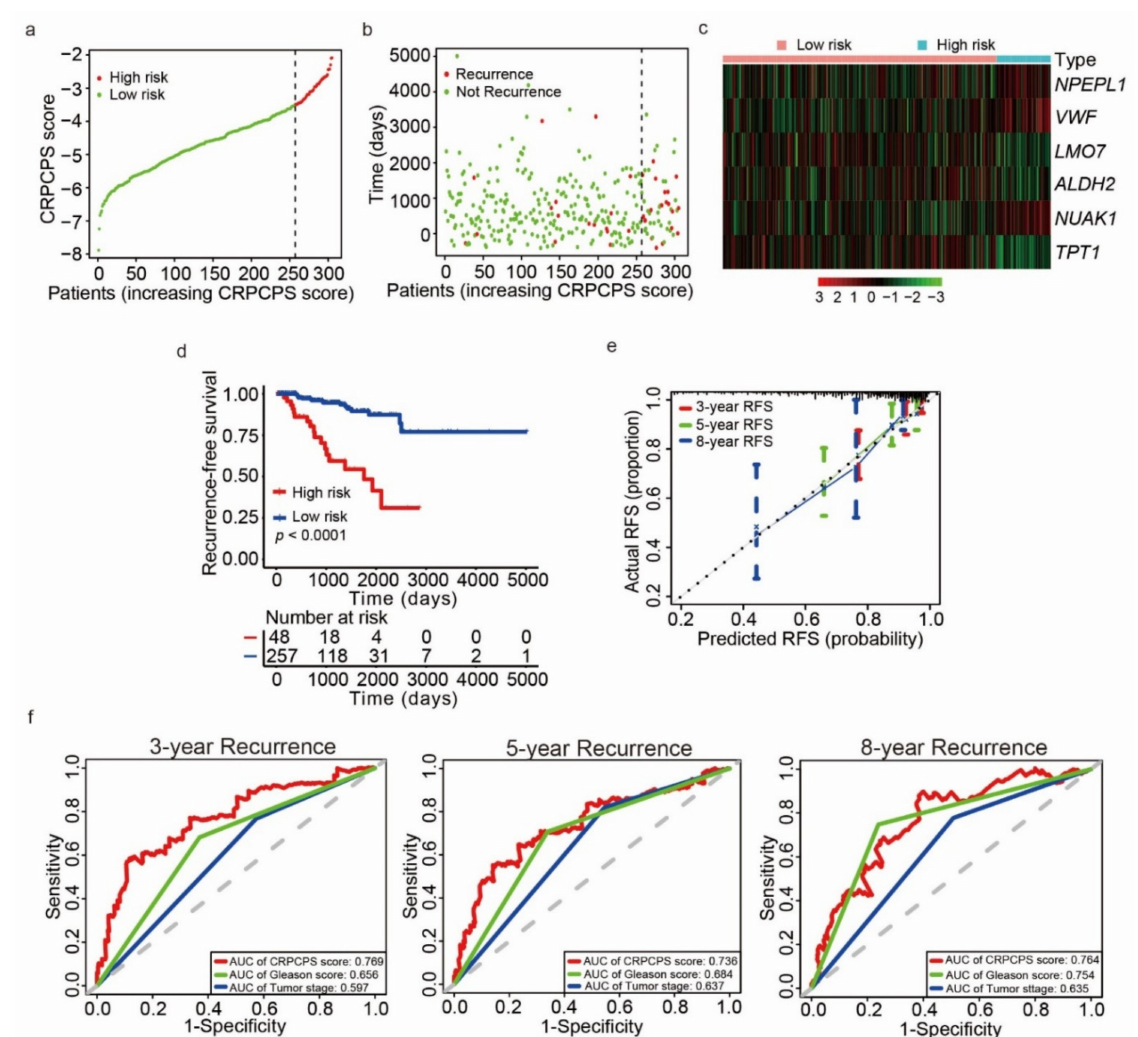
Figure 4. Construction of the CRPC-derived prognosis signature (CRPCPS) in the TCGA training cohort for predicting RFS in PCa. ( a – c ) Distribution of CRPCPS score, patients’ recurrent status, and expression pattern of the six CRPCPS genes in the TCGA training cohort, respectively. ( d ) Kaplan–Meier curves of recurrence-free survival (RFS) according to CRPCPS score in the TCGA training cohort. ( e ) Calibration curves of the CRPCPS for predicting RFS probability at 3, 5, and 8 years in the TCGA training cohort. ( f ) Receiver operating characteristic (ROC) curves of the CRPCPS score, Gleason score, and pathological tumor stage were performed to evaluate the predictability of RFS at 3 (left), 5 (center), and 8 years (right) in the TCGA training